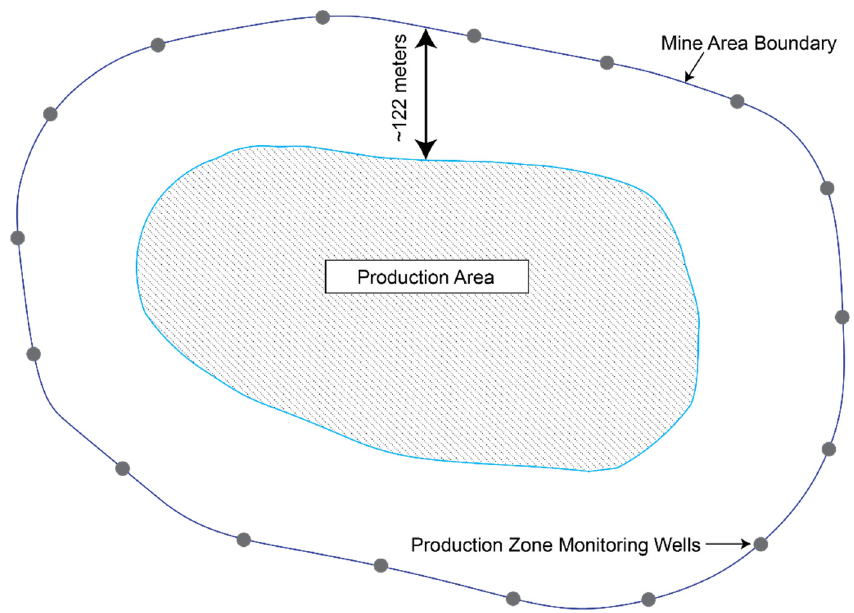
Figure 9. Schematic of in-situ-recovery mine showing production area, mine area, and monitoring wells (gray dots) 122 m (about 400 ft) from production area. Modified from [109].